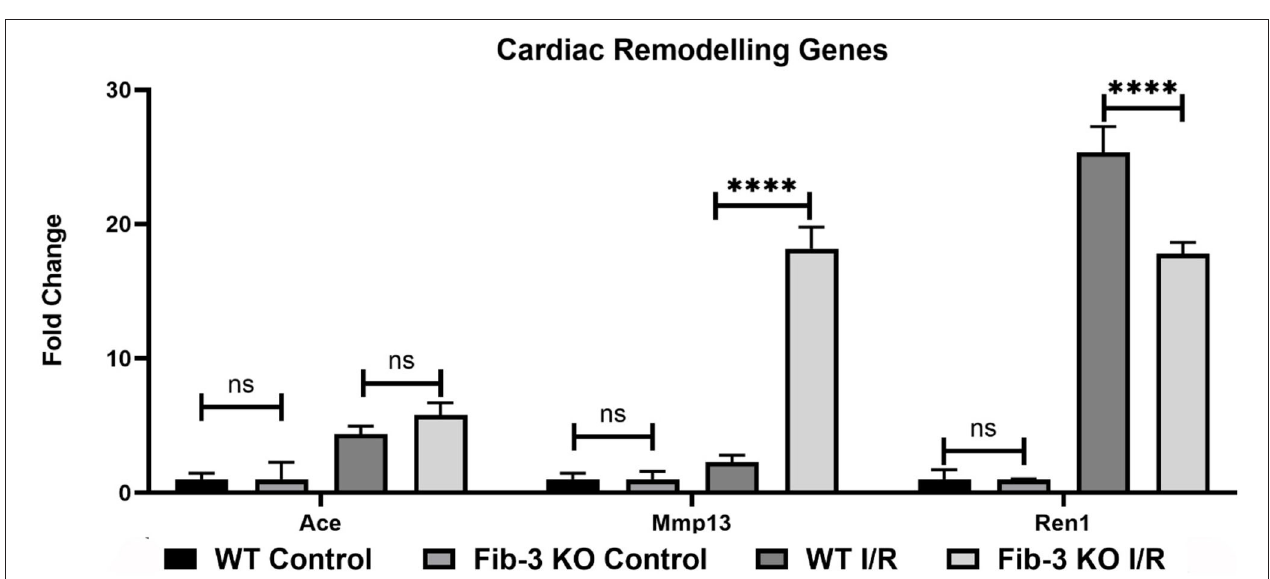
Fib-3 degrades collagen type 2 (Col2) whereas suppression of Fib-3 significantly increased Col2 in mice and rats (38,